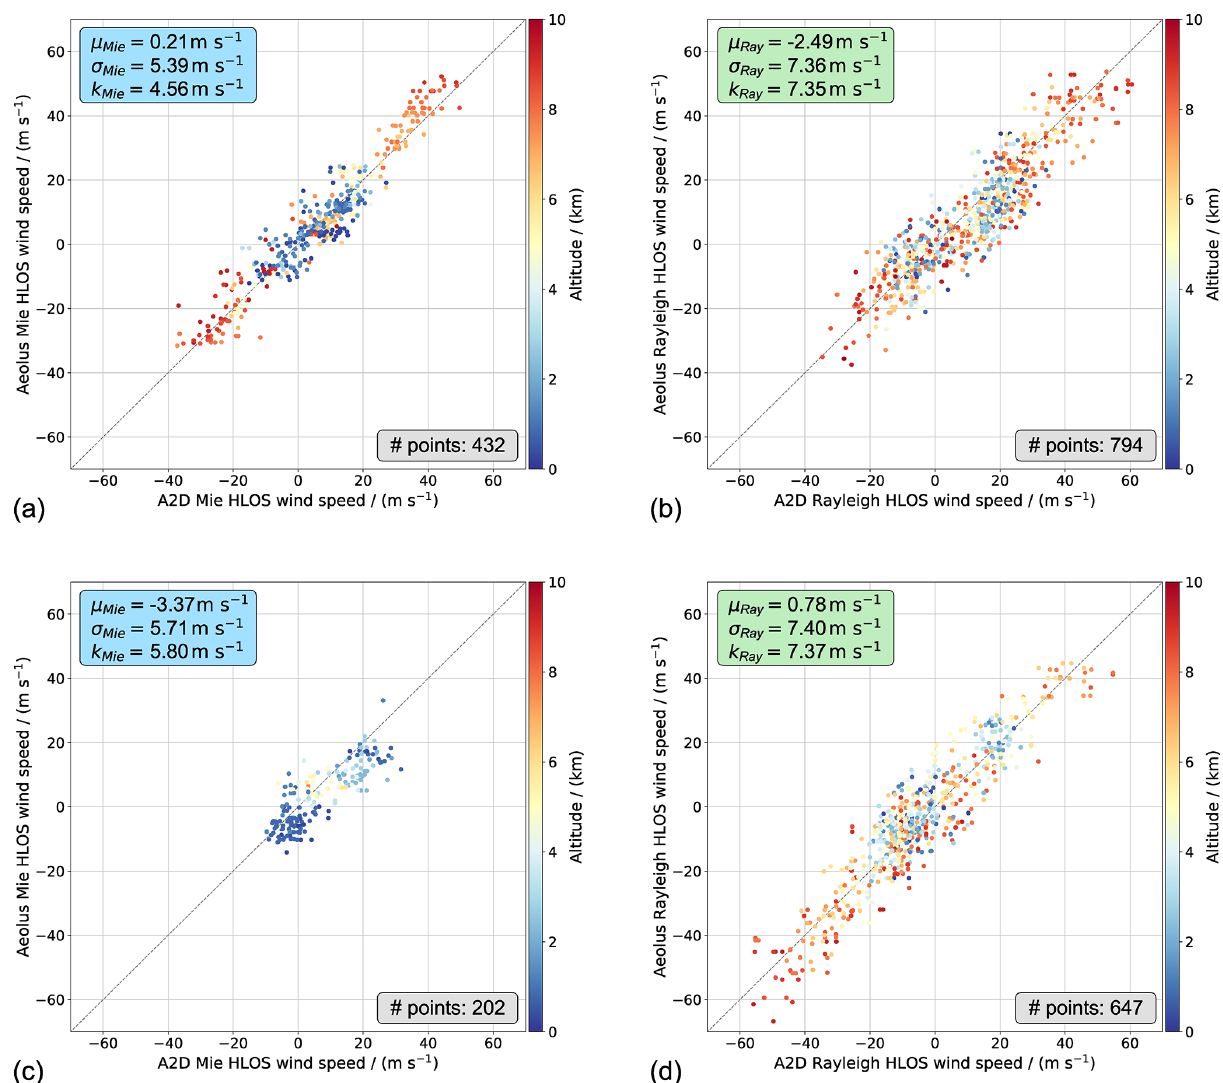
Figure 12. Scatterplots comparing the Aeolus L2B Mie-cloudy (a) and Rayleigh-clear winds (b) with the A2D Mie and Rayleigh winds from all underflight legs along ascending orbits during the AVATARI campaign. The bottom panels show the corresponding scatterplots for the Mie (c) and Rayleigh (d) lidar–lidar comparison from all underflight legs along descending orbits of the satellite. The data points are colour-coded with respect to the bottom altitude of the respective bins used for comparison. The mean bias ( µ ), standard deviation ( σ ), and scaled MAD ( k ) are provided in the respective